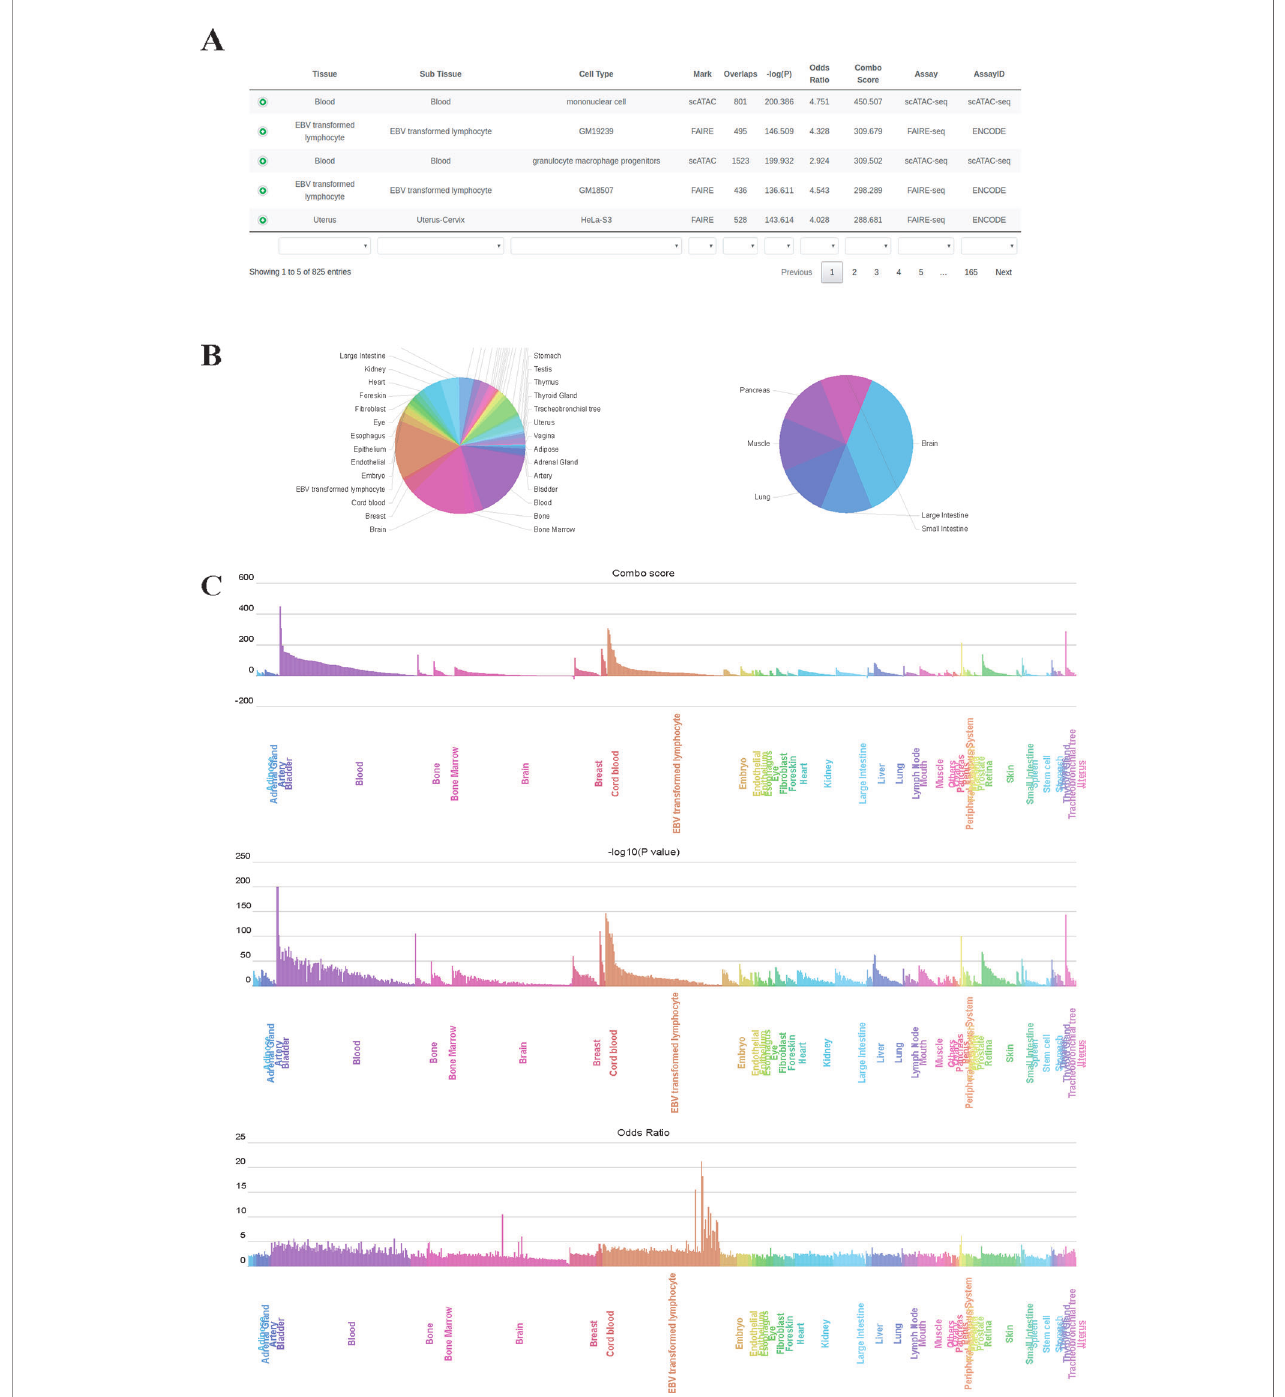
FIGURE 2 | Results page of epiCOLOC. Colocalization result for IBD GWAS variants in open chromatin regions, (A) Prioritization table. (B) Pie chart that depicts the number of signi fi cant enriched or depleted pro fi les in each tissue. (C) Bar plots that display ordered combo score, P -value, odds ratio in tissue-wise